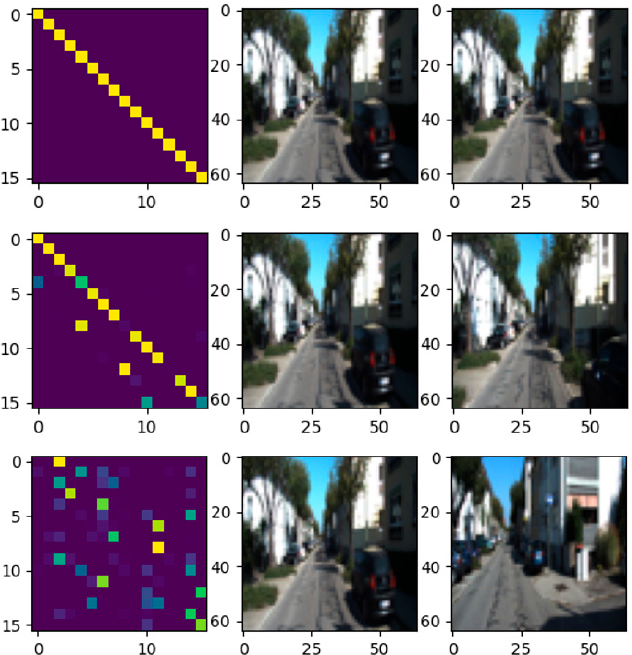
Figure 5. Correlation distribution φ and input image: top, φ with identical input images, and the output from the similar network is1 × 10 − 6 ; middle, φ with similar input images (difference between 5 frames), and the similar network output is 0.653; bottom, φ with completely different input images (difference between 50 frames), and the similarity is 0.998.